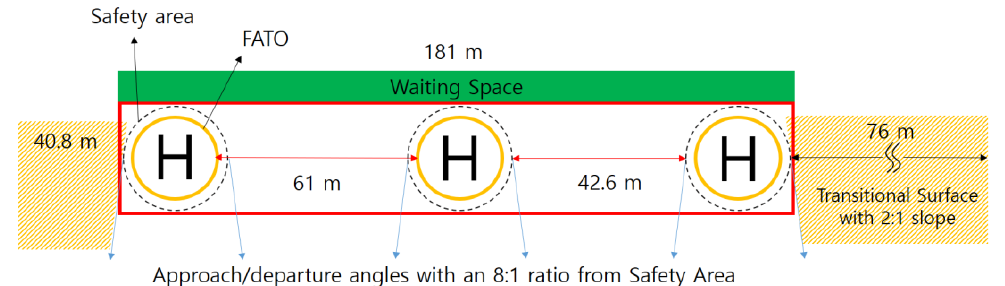
Figure 9. Example of linear topology that complies with the FAA’s new regulations.